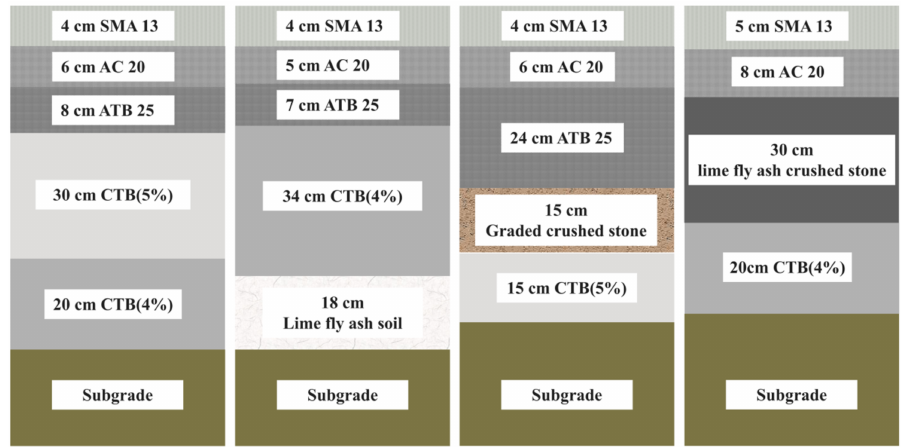
Figure 2. Four typical pavement structure